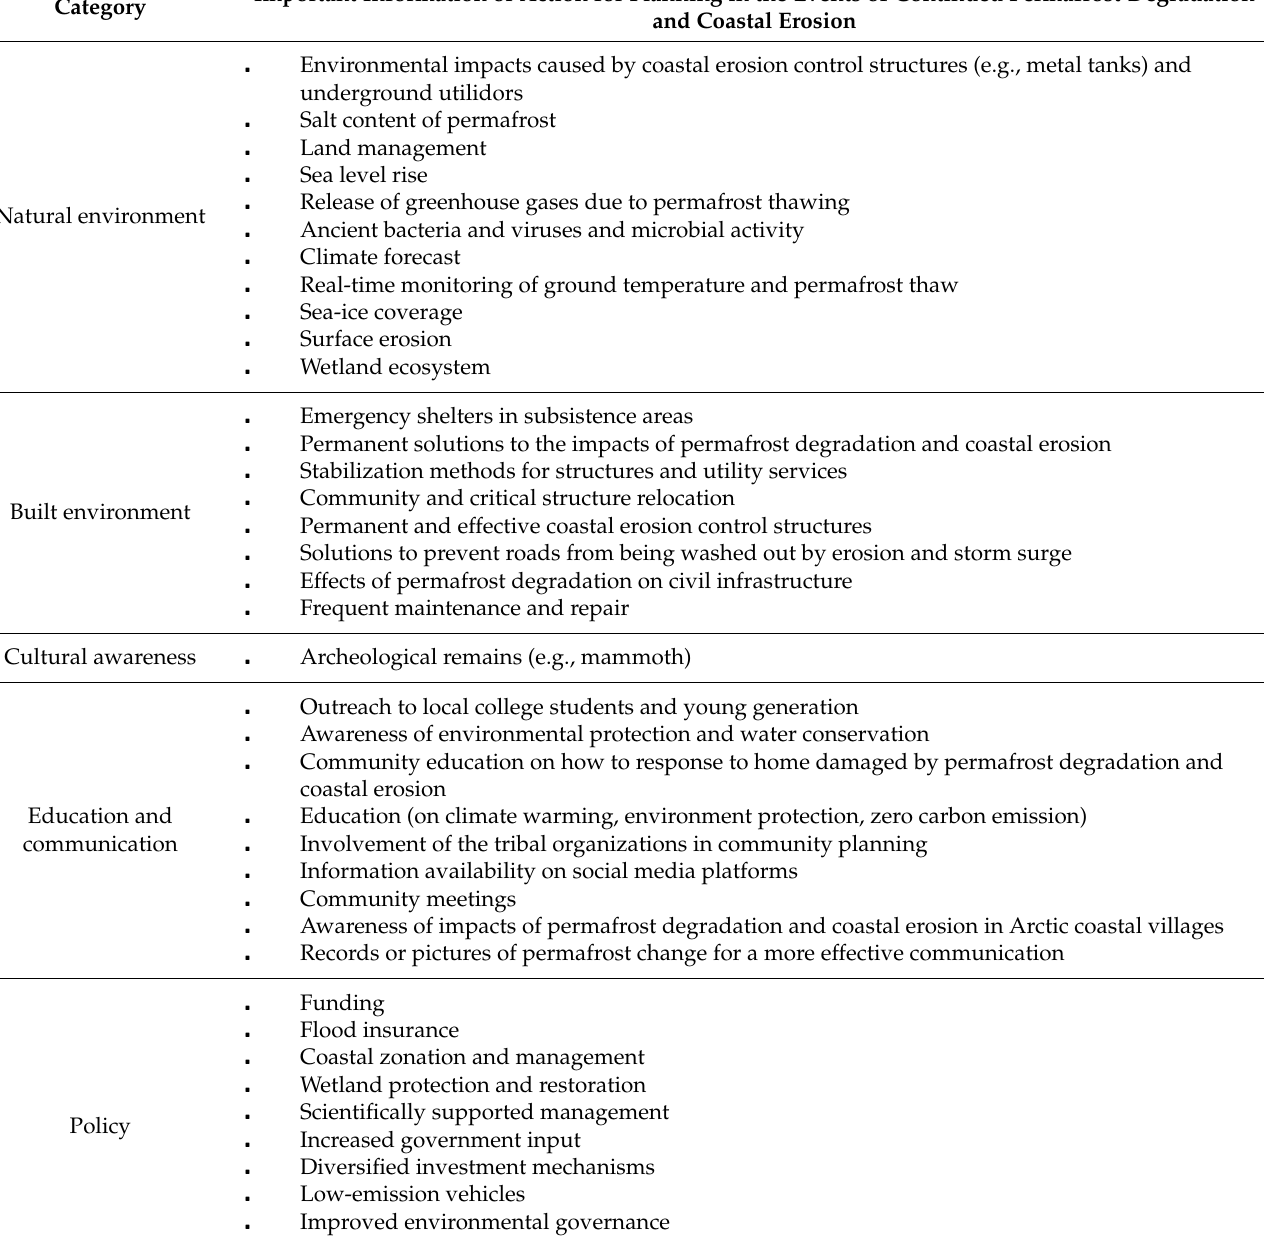
Table 7. Important information or action for planning in the events of continued permafrost degrada- tion and coastal erosion (according to the survey